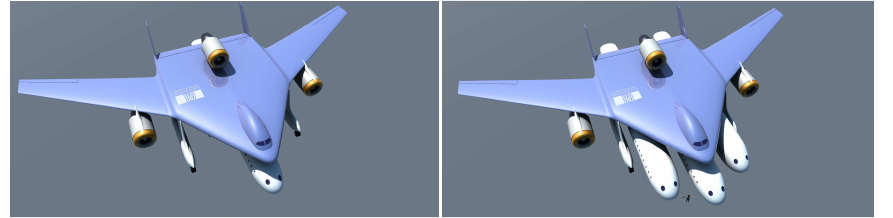
Figure 1. Clip-Air wings and